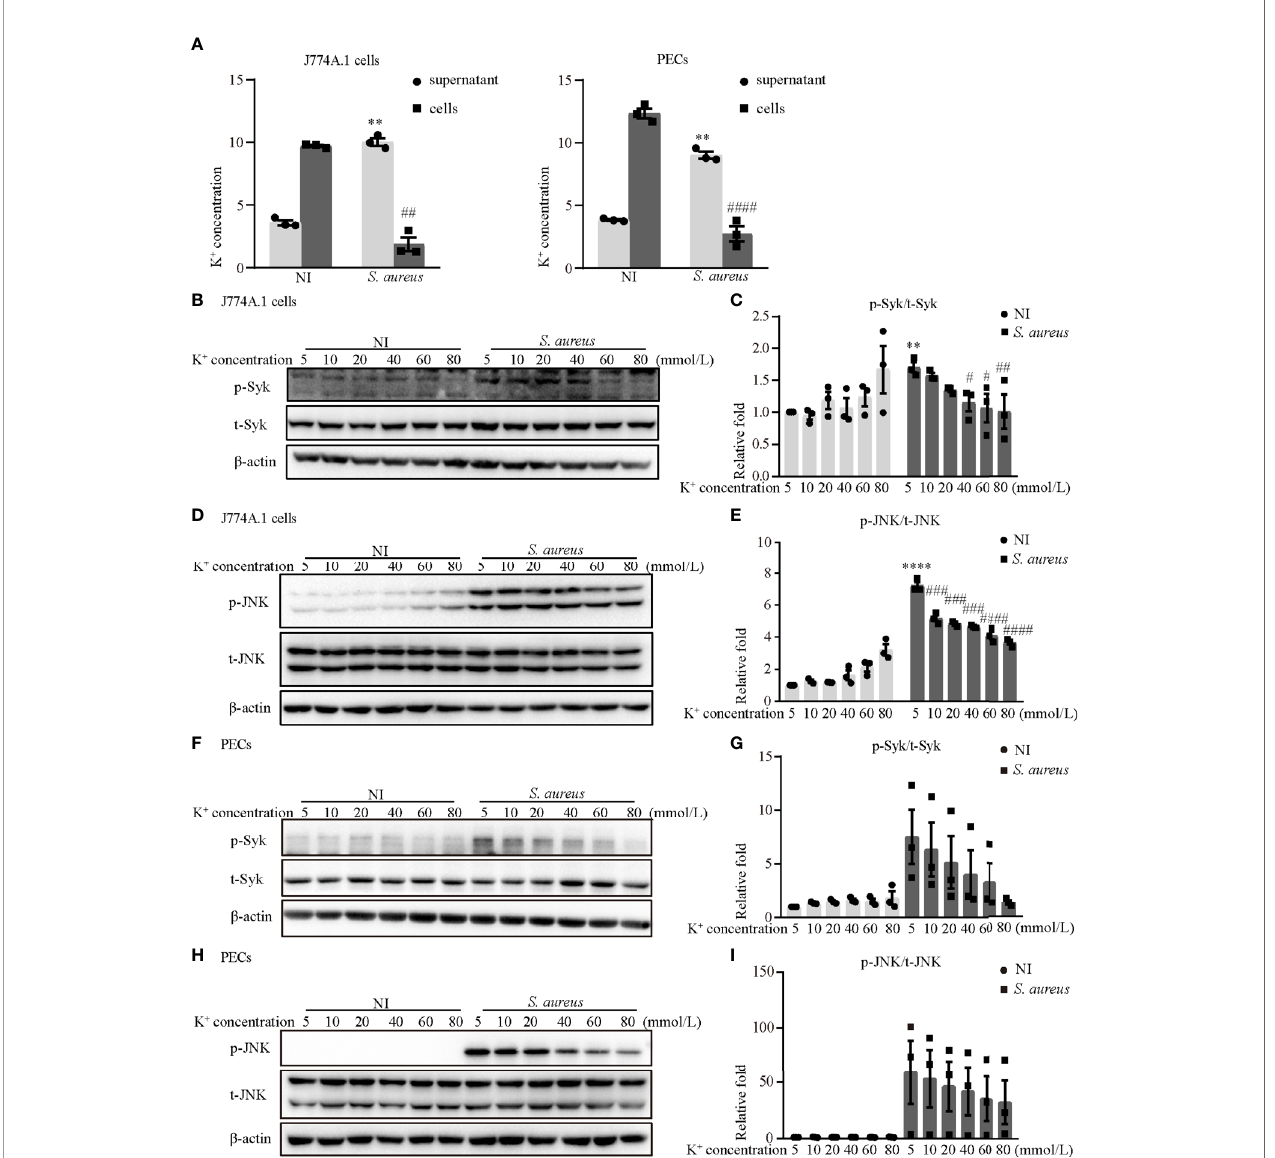
FIGURE 8 | Blockade of potassium ef fl ux decreased the phosphorylation levels of Syk and JNK upon S. aureus infection. (A) K + concentration in the supernatant and cells of J774A.1 cells and PECs infected with S. aureus (MOI of 1) for 24 h (B – I) J774A.1 cells and PECs were infected with S. aureus (MOI of 5) for different time in the presence of following treating with increasing concentration of KCl (5 mM-80 mM). The cell lysates were collected at 0.5 h and 2 h. (B) The protein levels of t-Syk and p-Syk were detected by western blot in J774A.1 cells and PECs (F) . (C) Relative densitometric quanti fi cation analysis of p-Syk/t-Syk in J774A.1 cells and PECs (G) . (D) The protein levels of t-JNK and p-JNK were detected by western blot in J774A.1 cells and PECs (H) . (E) Relative densitometric quanti fi cation analysis of p-JNK/t-JNK in J774A.1 cells and PECs (I) . Similar results were obtained in three independent experiments in data. Data shown are means ±